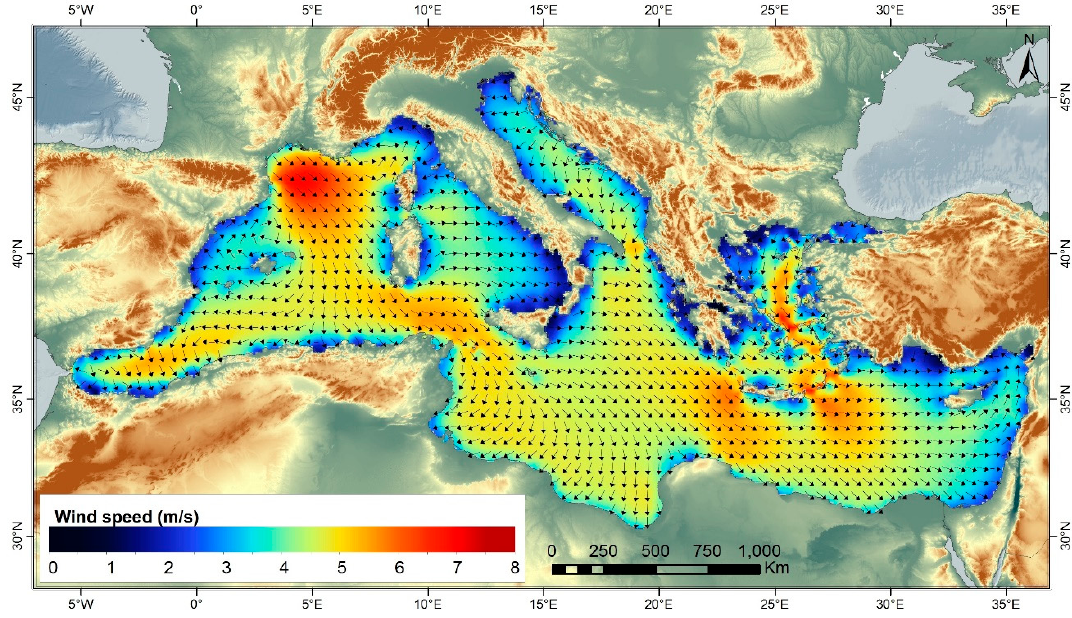
Figure 6. Mean annual wind climate (at 10 m above sea level) in the Mediterranean Sea according to the ETA model. Arrows indicate the mean annual wind direction (Source: [107]). Data analyzed by HCMR.